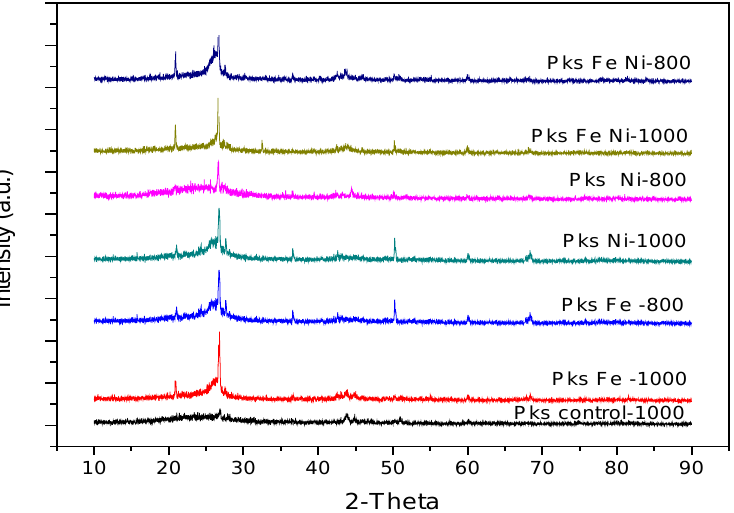
Figure 1. XRD pattern for PKS sample prepared with different temperatures and catalysts.